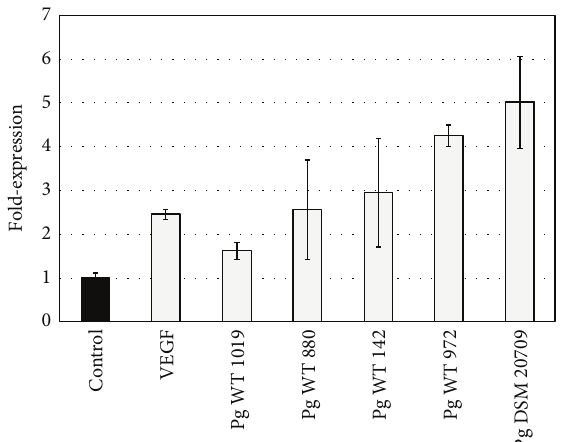
Figure 5: Expression of cox2 in endothelial (HUVEC) cells. Expres- sion of cox2 following 2 h incubation with medium (negative con- trol), VEGF (positive control), and P. gingivalis strains DSM 20709, WT 149, WT 880, WT 972, and WT 1019. Error bars indicate ±